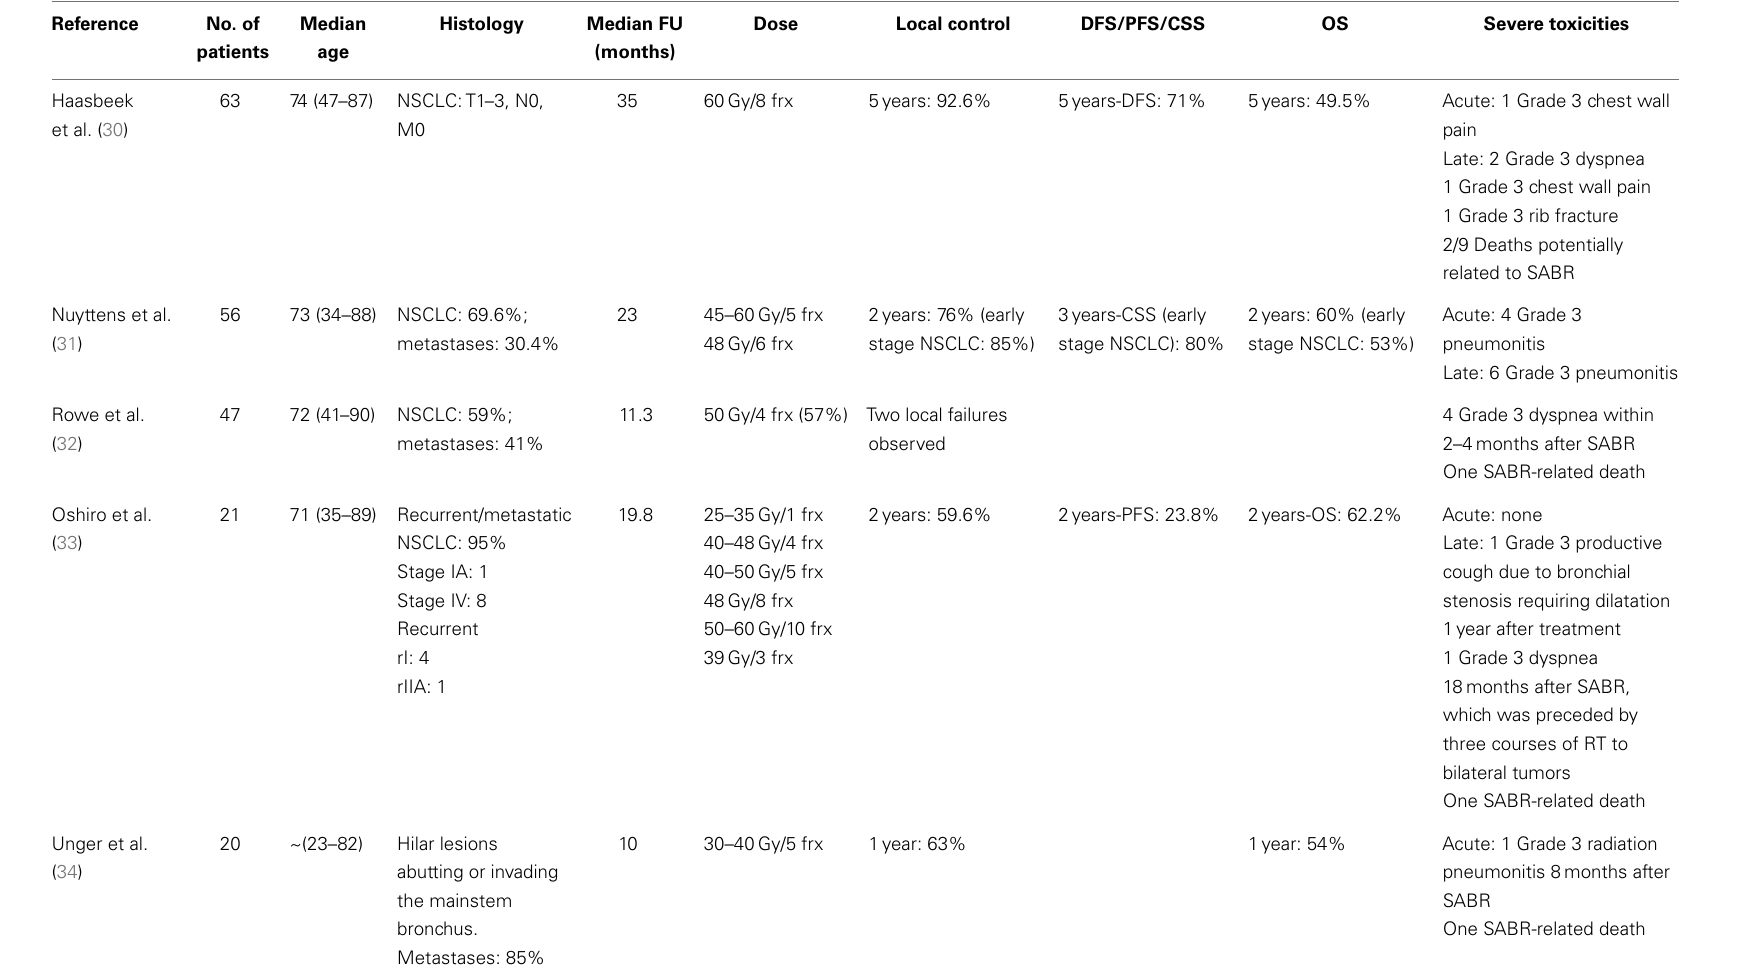
Table 1 | Clinical outcome following SABR for centrally located lung tumors alone .